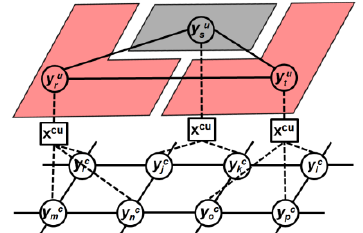
Figure 1. Graphical model consisting of two layers: land cover layer (c) and land use layer (u). Nodes are depicted as circles, intra-layer edges as solid lines, inter-layer observations as rectangles connected to the dependent nodes by dashed lines.